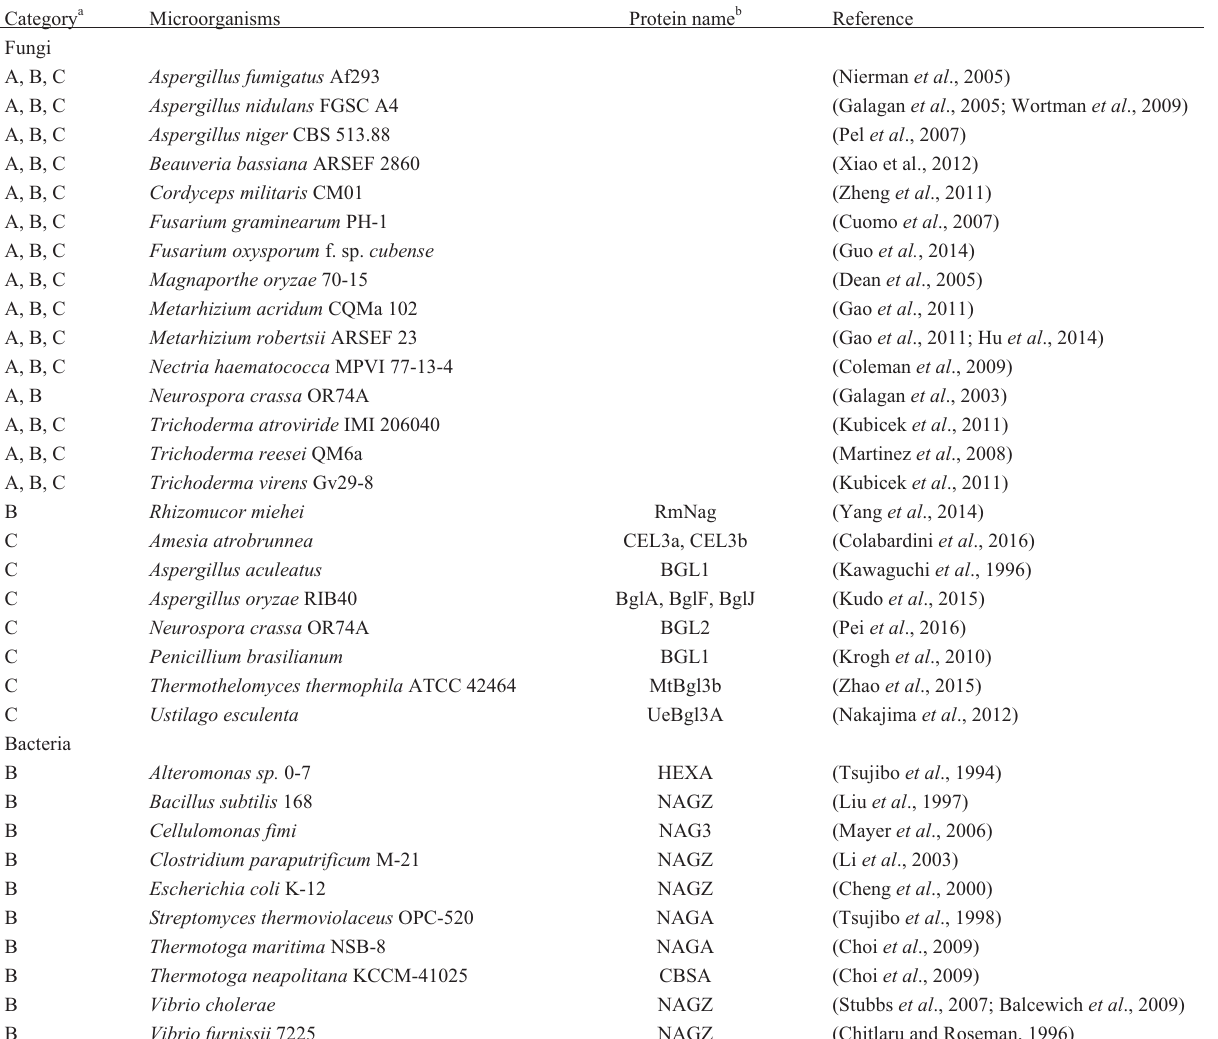
Table 1 - List of microorganisms used in GH20 and GH3 NAGases phylogenetic